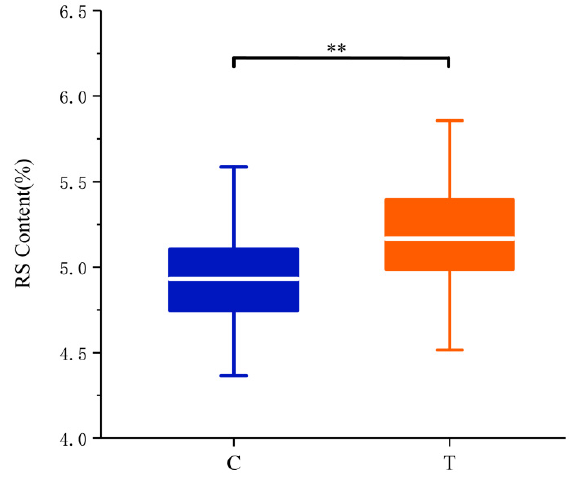
Figure 5. The effect of the AX-94546744 SNP on RS content in the association population. The blue and orange bars represent the RS content of vaireties with AX-94546744 -C and AX-94546744 -T in the association population. The genotype of the SNP is labeled under the x -axis. The y -axis indicates the RS content of each group. ** indicates the significance differences among the various genotypes at p < 0.01 level (ANOVA).